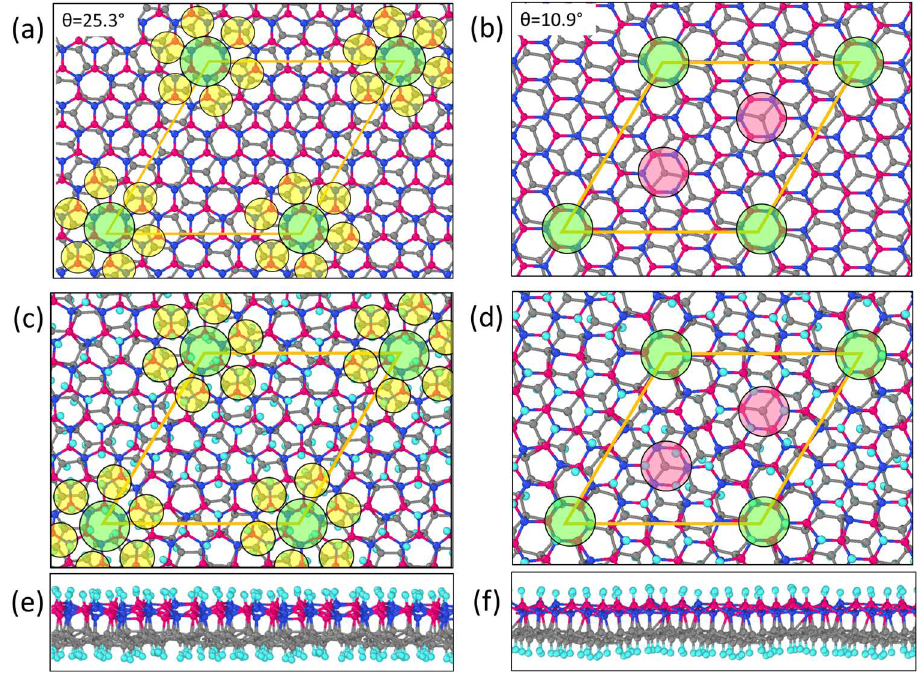
Figure 2. Structural features of twisted G/BN bilayers with θ = 25.3° ( a ) and θ = 10.9° ( b ). Top ( c , d ) and side ( e , f ) views of the diamane-like structures based on bilayers ( a , b ), respectively. C-C and B-N bond “crossings” are marked by yellow circles, AA-stacked areas are marked by green circles and AB-stacked areas are marked by red circles. Structure ( c ) has three interlayer C-N bonds in AA-stacked area, and structure ( d ) has three C-B interlayer bonds.